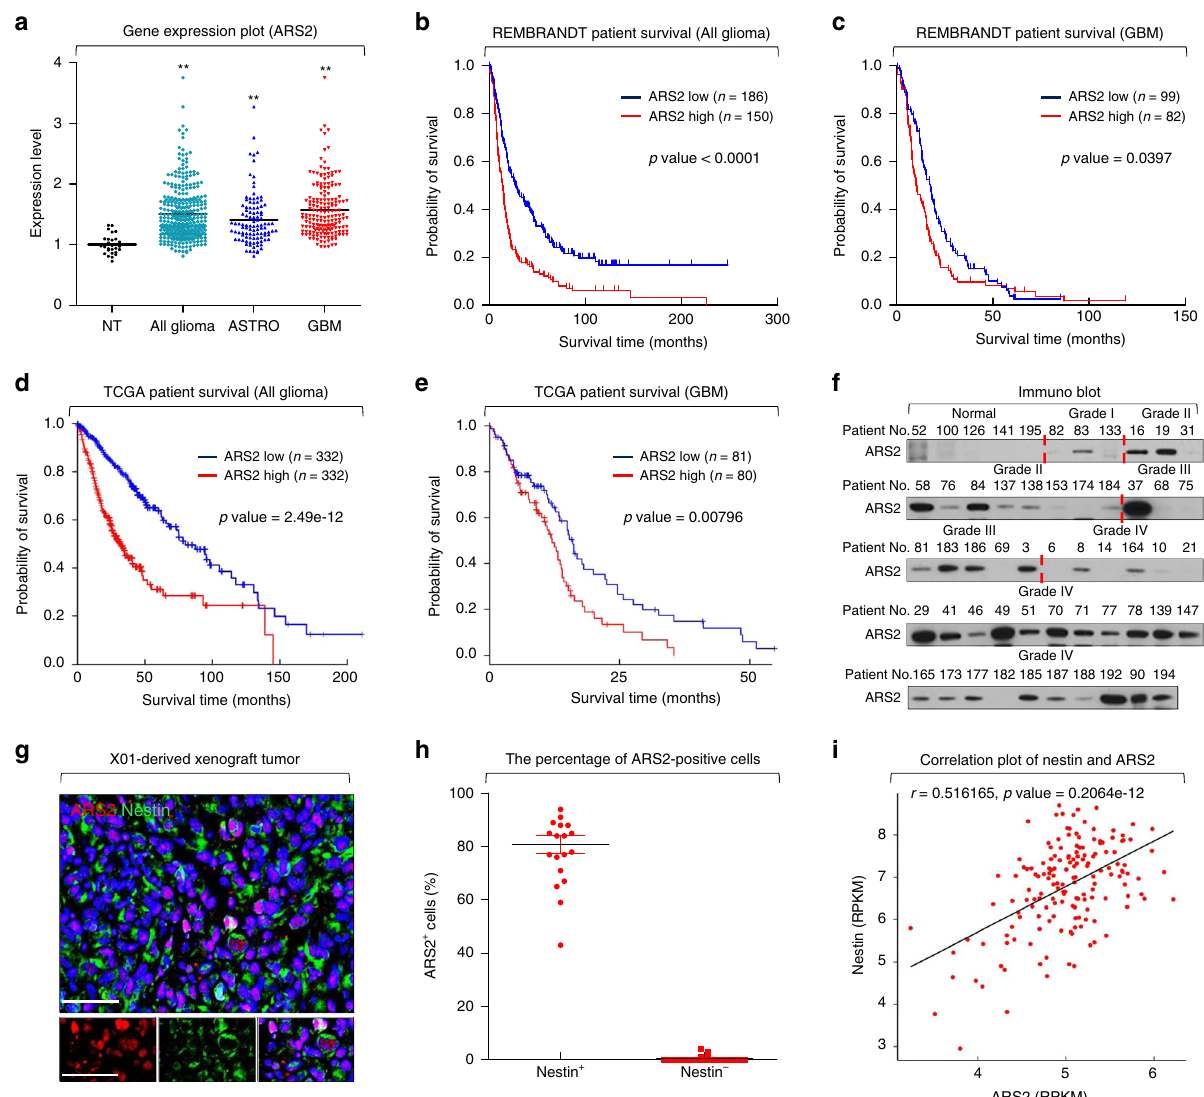
Fig. 1 ARS2 is highly expressed in high-grade brain tumors. a ARS2 expression in each type of brain tumor from the REMBRANDT database. b , c Kaplan – Meier survival plots for all glioma patients and GBM patients with high and low ARS2 expression. Data were obtained from the REMBRANDT of the National Cancer Institute (log-rank test). d , e Kaplan – Meier survival plots for all glioma patients and GBM patients with high (top 50% contribution) and low (down 50% contribution) ARS2 expression. Data were obtained from the TCGA database. f Immunoblot (IB) analysis of ARS2 in patient tissues from the National Cancer Center, Republic of Korea. GAPDH was used as a loading control 45 . g Representative immuno fl uorescence (IF) image of ARS2 and Nestin expression in GBM xenografts derived from X01 cells. Nuclei were counterstained with DAPI (blue). Scale bar, 50 μ m. h Percentage of ARS2- positive cells among Nestin-positive and -negative cells. Lines show means and ±SD. i Correlation dot-plot of ARS2 and Nestin from the TCGA database ( n = fi ndings indicate that ARS2 is required for GSC proliferation and is essential for regulating GSC self-renewal and glioma tumorigenicity.